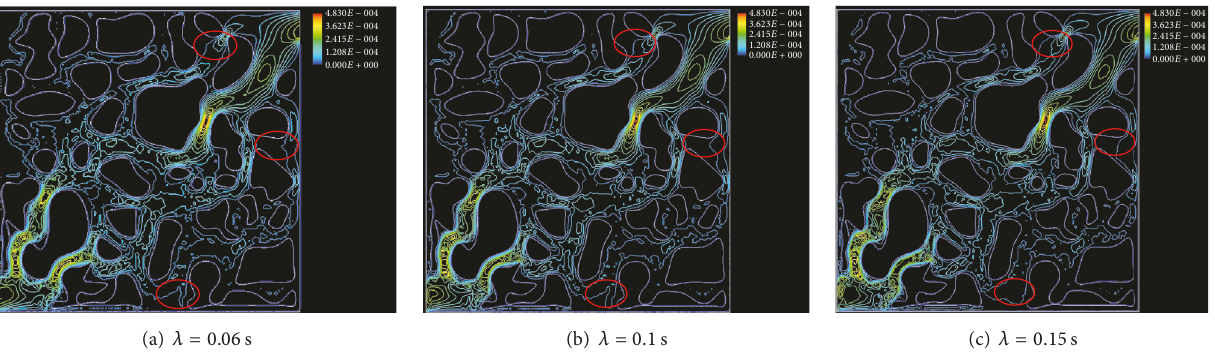
Figure 11: Local velocity contours with different relaxation time through complex micromodel ( 𝑡 = 2.0 s).